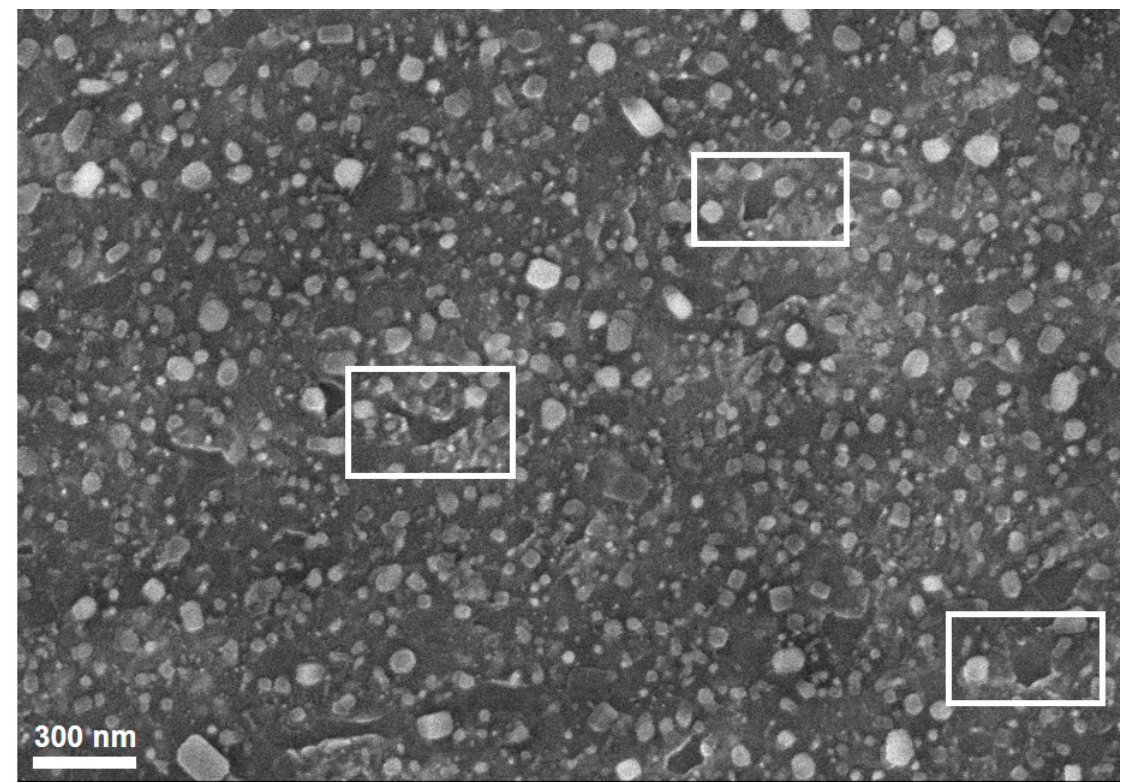
Figure 7. Melting points in the SEM image of the catalyst after pretreatment at 950 °C. Rectangles indicate melting point area.